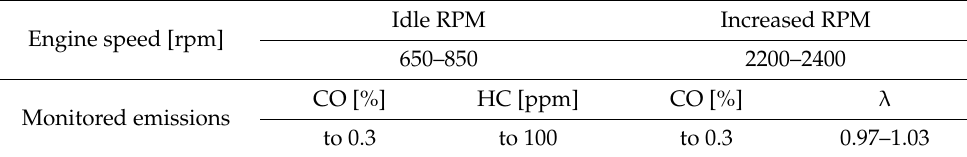
Table 5. Emission values for the monitored vehicle